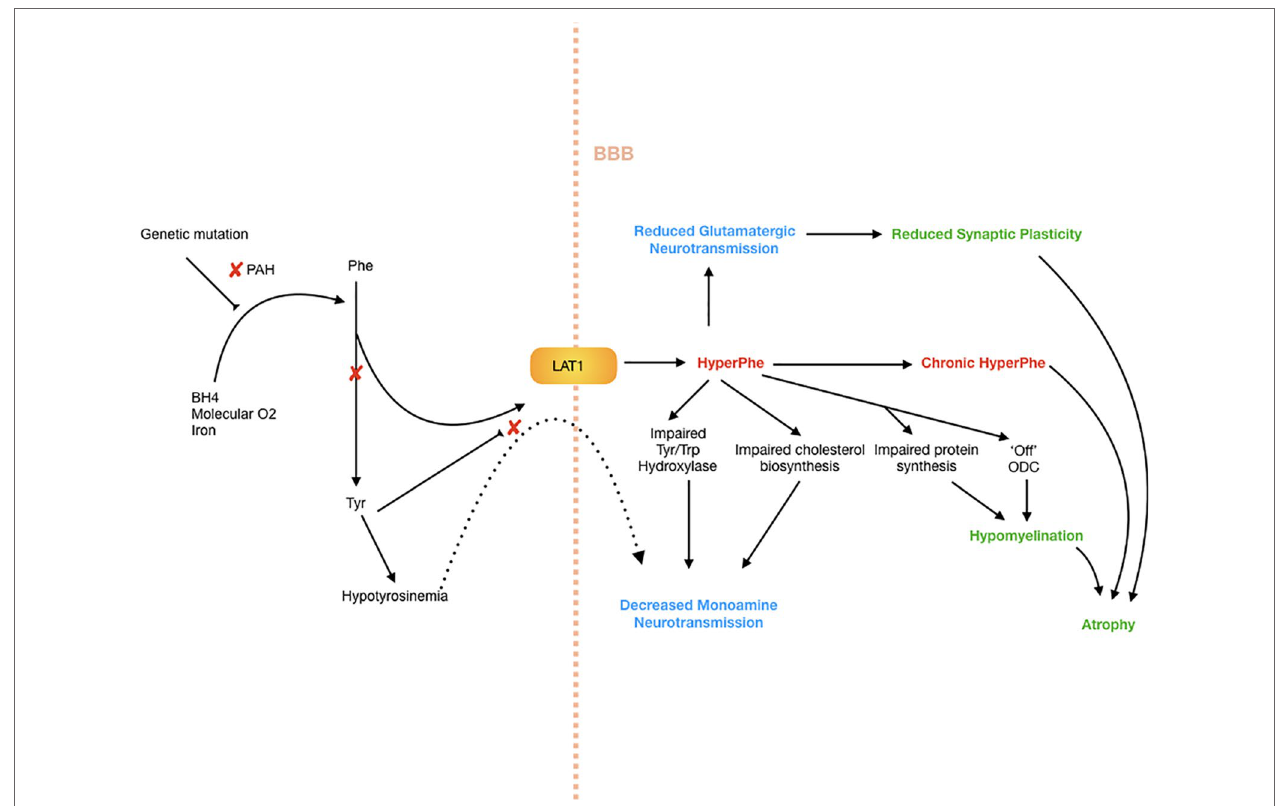
FIGURE 1 | Neuropathophysiology of PKU. Decreased PAH activity results in hyperphenylalaninemia as well as hypotyrosinemia. The high Phe levels further restrict transport of tyrosine across the blood–brain barrier, as well as impairing tyrosine and tryptophan hydroxylase systems, as well as cholesterol synthesis, creating a hypomonoaminergic state in the brain, predominantly in frontal and limbic circuits where these neurotransmitters predominate. There is also reduced glutamatergic neurotransmission, which results in reduced synaptic plasticity, and in turn atrophy. Myelination is critically affected by high Phe levels, which impair protein synthesis, as well as switch oligodendrocytes to an “off” or non-myelinating